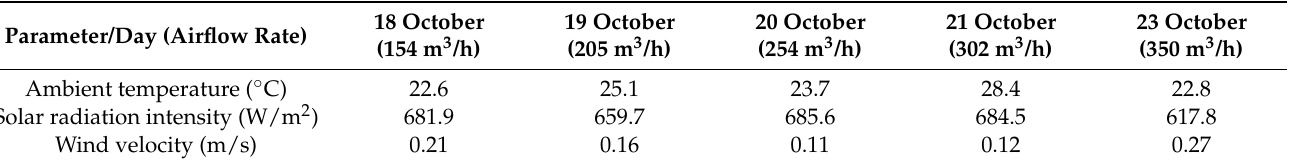
Table 3. GTC configuration: 50 mm-distance absorber—glazing. Mean values of meteorological parameters (time interval: 13:10–14:10) 1 .